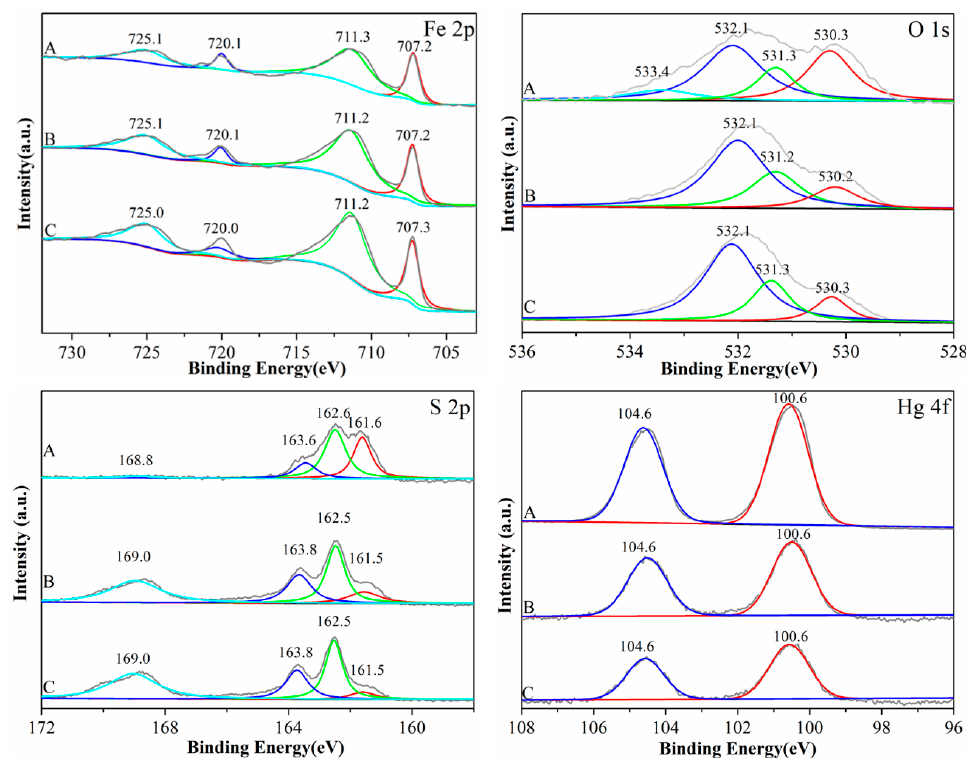
Figure 9. XPS spectra(Fe 2p, O 1s, S 2p and Hg 4f) of the MPy column (( A ): bottom, ( B ): middle, and ( C ): top).